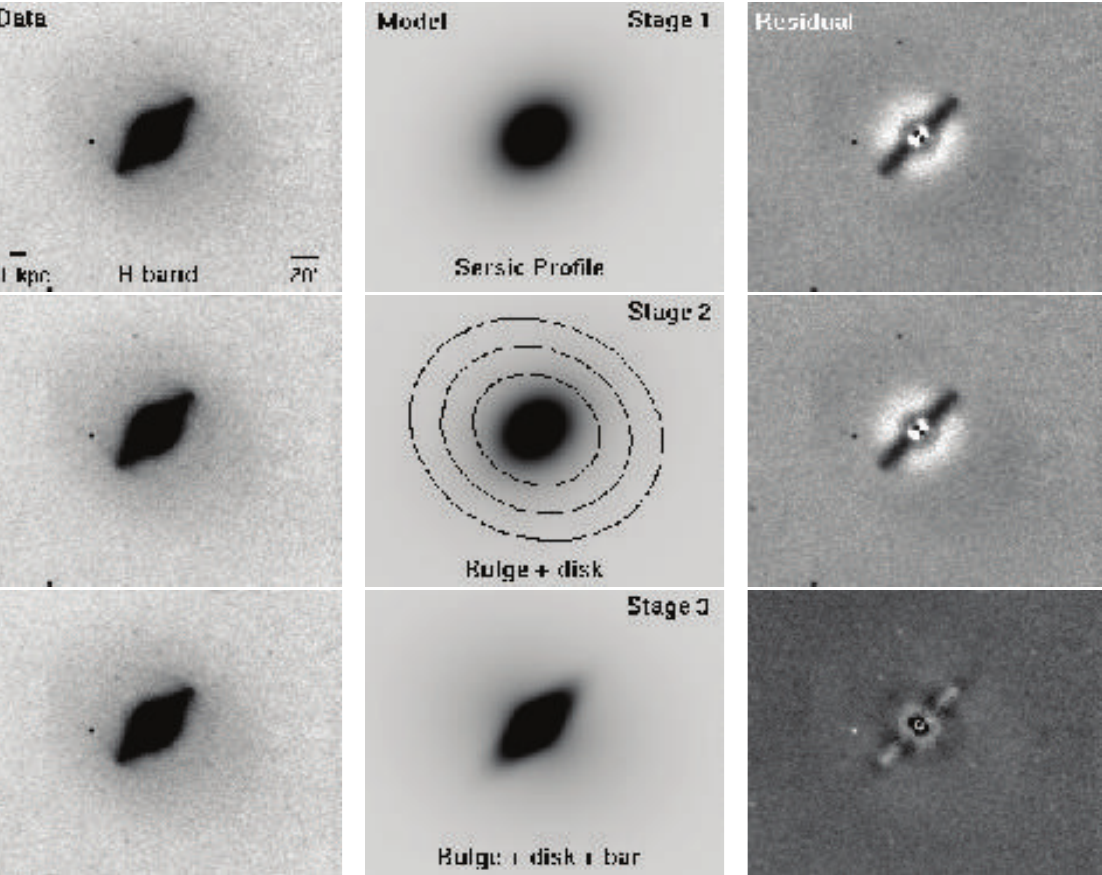
Figure 5: (left panels) r-band images the NGC4643. S´ersic (middle upper panel), S´ersic plus disc (middle middle panel), and S´ersic plus disc plus bar (middle-lower panel) models of the galaxy. (right panels) the corresponding residuals. Credit: Weinzirl et al. [73]. Reproduced by permission from the AAS.